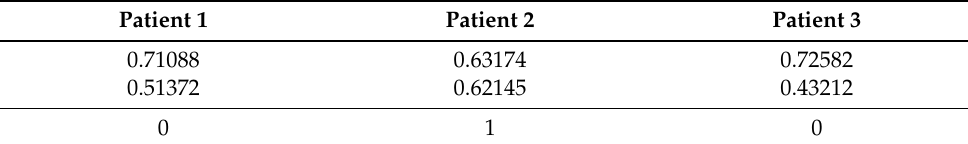
Table 4. Multiple patient methylation data.